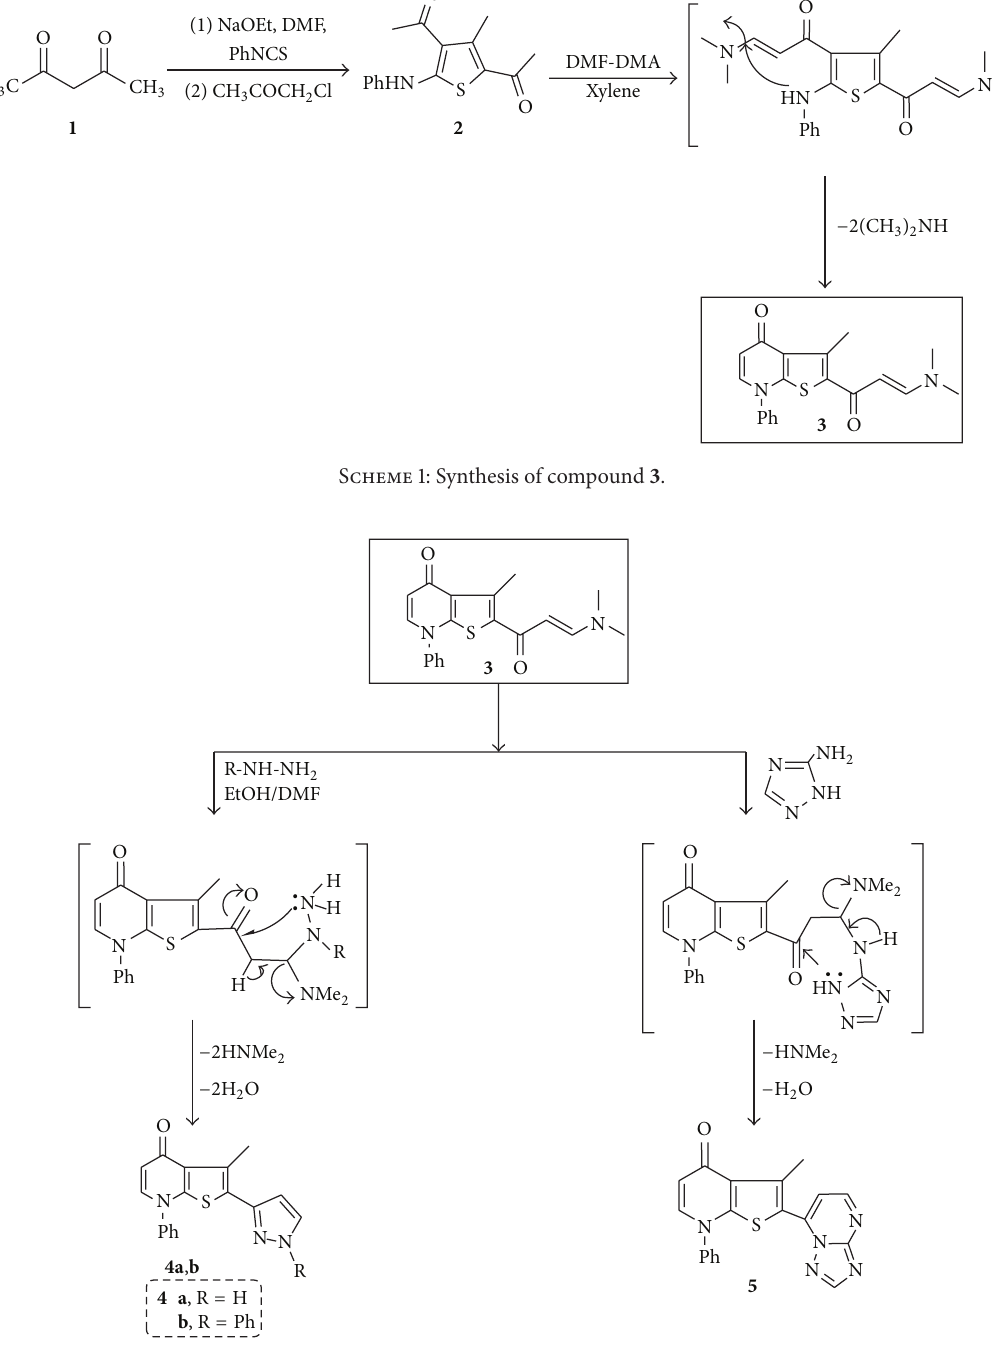
Scheme 2: Synthesis of compounds 4a , b and 5